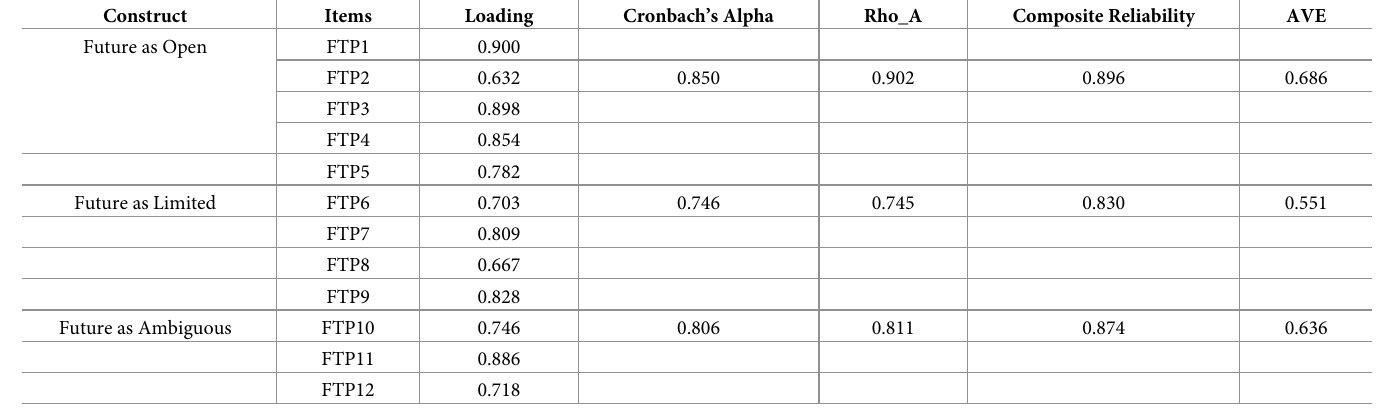
Table 8. Future time perspective measurement